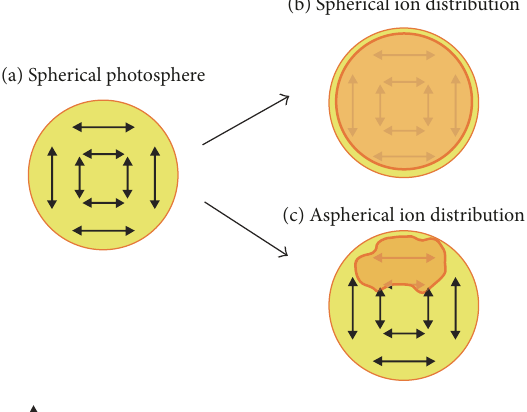
Figure 12: Schematic illustration of polarization in the SN ejecta. (a) When the photosphere is spherical, polarization is canceled out, and no polarization is expected. At the wavelength of a line, polarization produced by the electron scattering is depolarized by the line transition. (b) When the ion distribution is spherical, the remaining polarization is canceled, and no polarization is expected. (c) When the ion distribution is not spherical, the cancelation becomes incomplete, and line polarization could be detected (figure and caption taken from